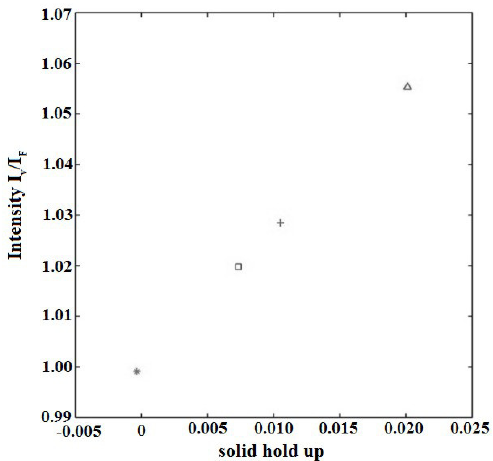
Fig. 3. Relative intensity I V / I F against the solid hold up of four samples.